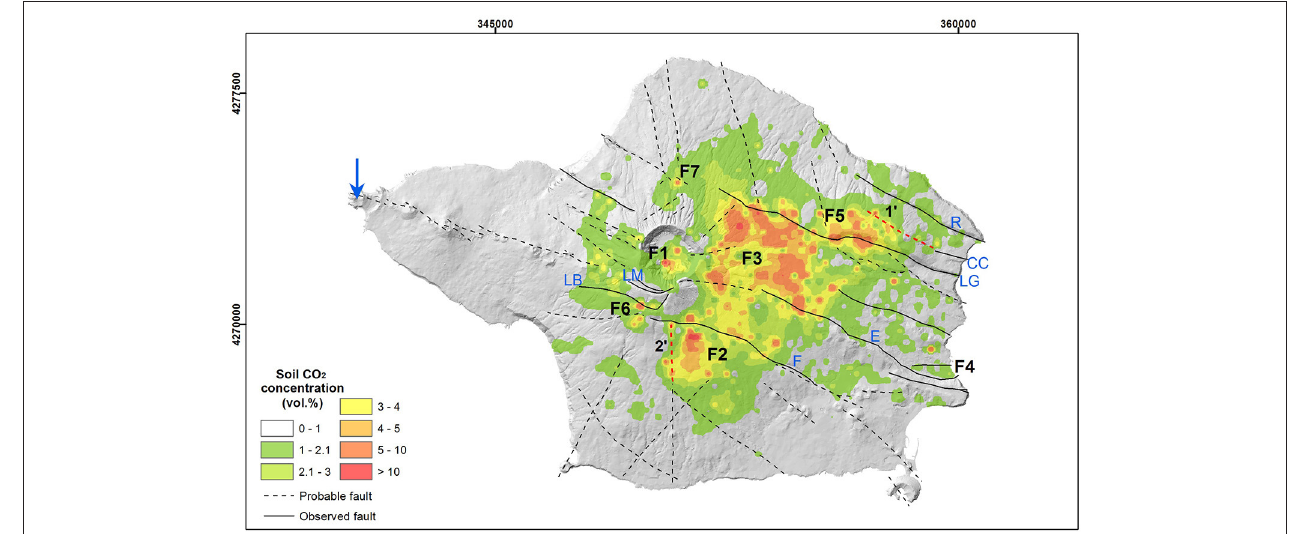
FIGURE 6 | E-type soil CO 2 concentration map for Faial Island (cell size = 50 × 50 m; interpolation method: sGs). Numbers F1–F7 represent the DDS identified at Faial Island, which correspond to areas where CO 2 is fed by hydrothermal sources (highlighted as orange and red—soil CO 2 concentration > 4 vol.%) (UTM(m)-WGS84, zone 26S). The blue arrow points to the location of the Capelinhos fumarolic field and red dotted lines represent degassing lineaments. Blue letters represent tectonic structures mentioned in the text: LB, Lomba de Baixo; LM, Lomba do Meio; F, Flamengos; E, Espalamaca; LG, Lomba Grande; CC, Chã da Cruz; R, Ribeirinha.